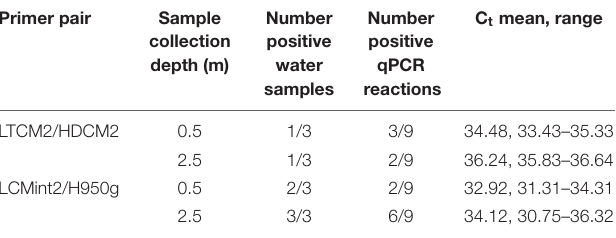
TABLE 4 | Time series of detection of Chelonia mydas eDNA in the Intake Channel of San Diego Bay after a sea turtle was removed from a net. Primer pair Time after C.